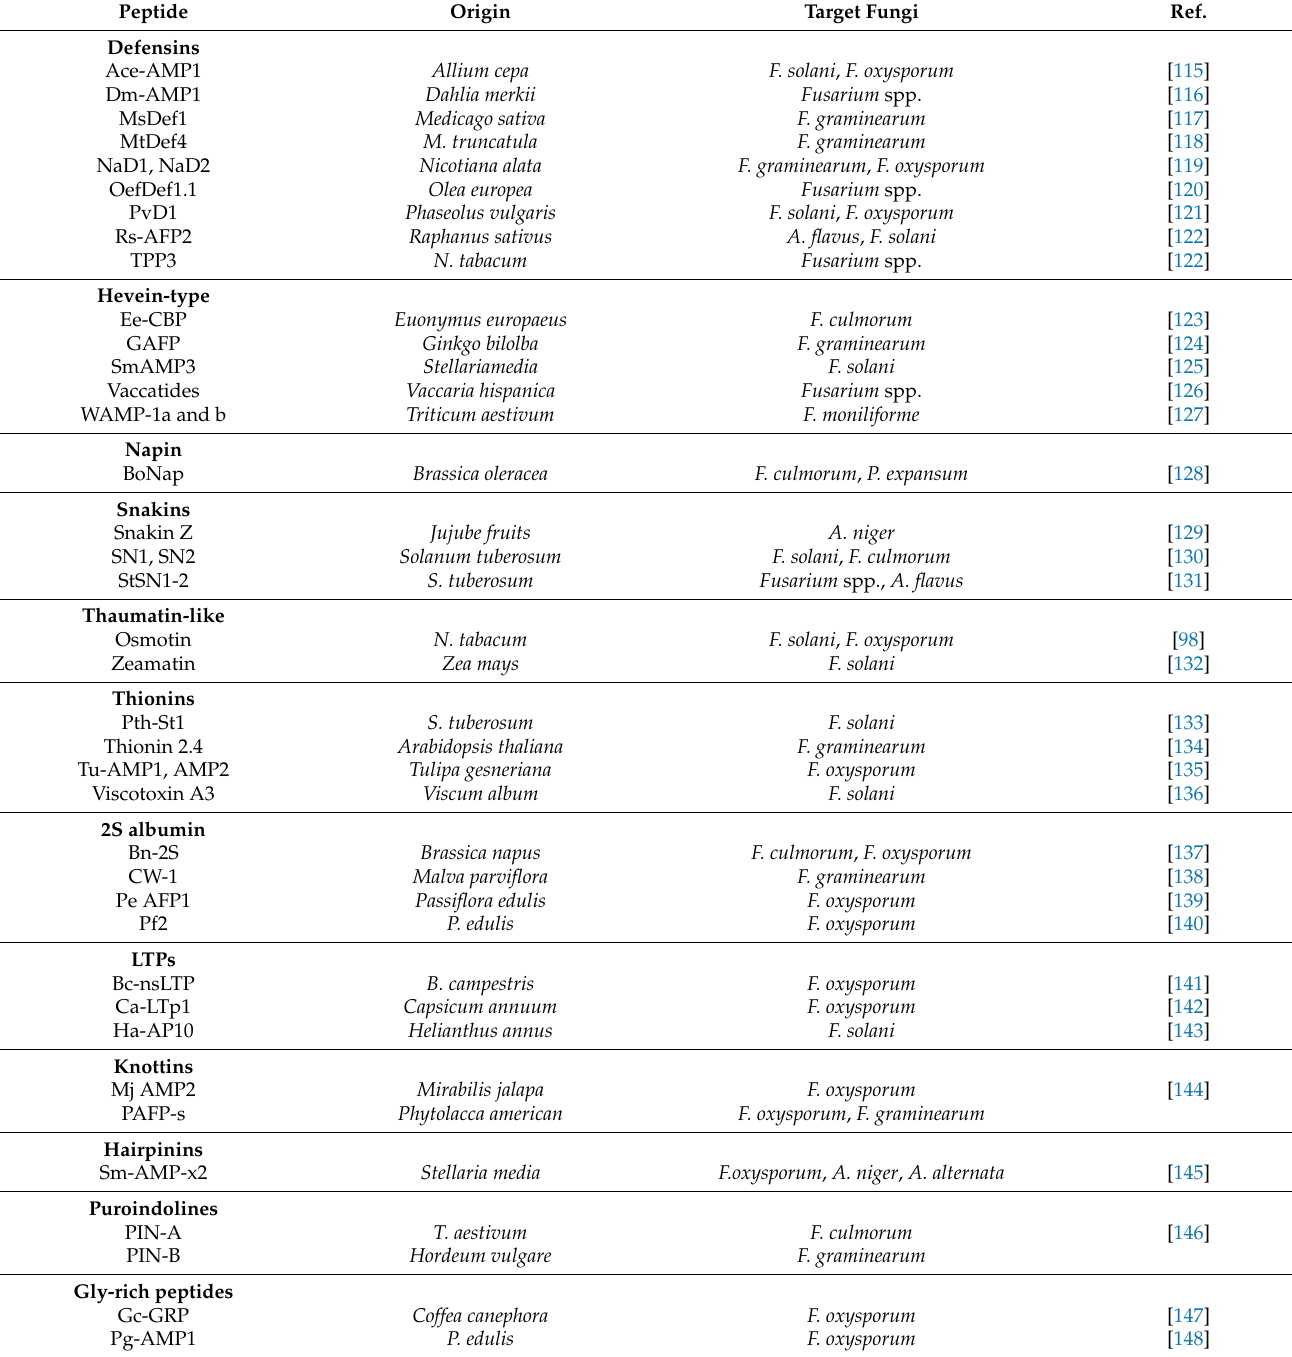
Table 2. Plant antifungal proteins and peptides with activity against mycotoxin-producing fungi. Peptide Origin Target Fungi